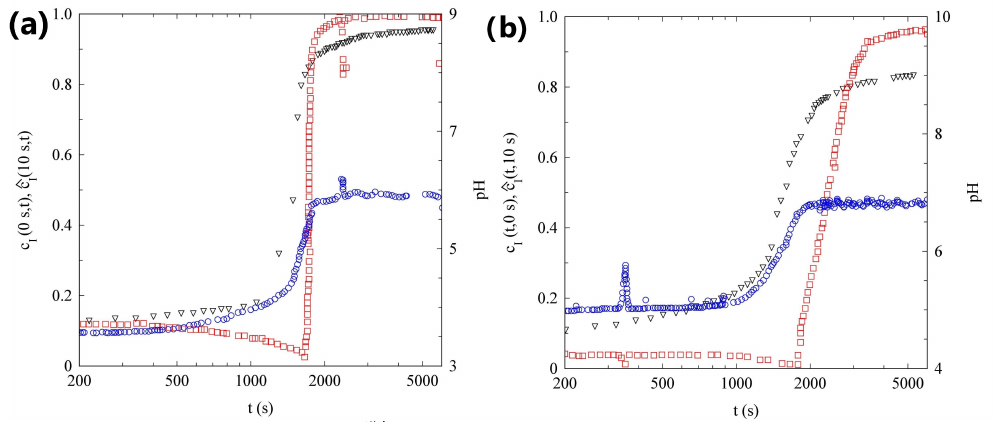
Figure 7. ( a ) Temporal evolution of the pH (triangles), c I ( 0s, t ) (circles), and ˆ c I ( 10s, t ) (squares) of sample H seeded with PMMA nanoparticles. ( b ) Temporal evolution of the pH (triangles), c I ( 0s, t ) (circles), and ˆ c I ( 10s, t ) (squares) of sample L seeded with PMMA